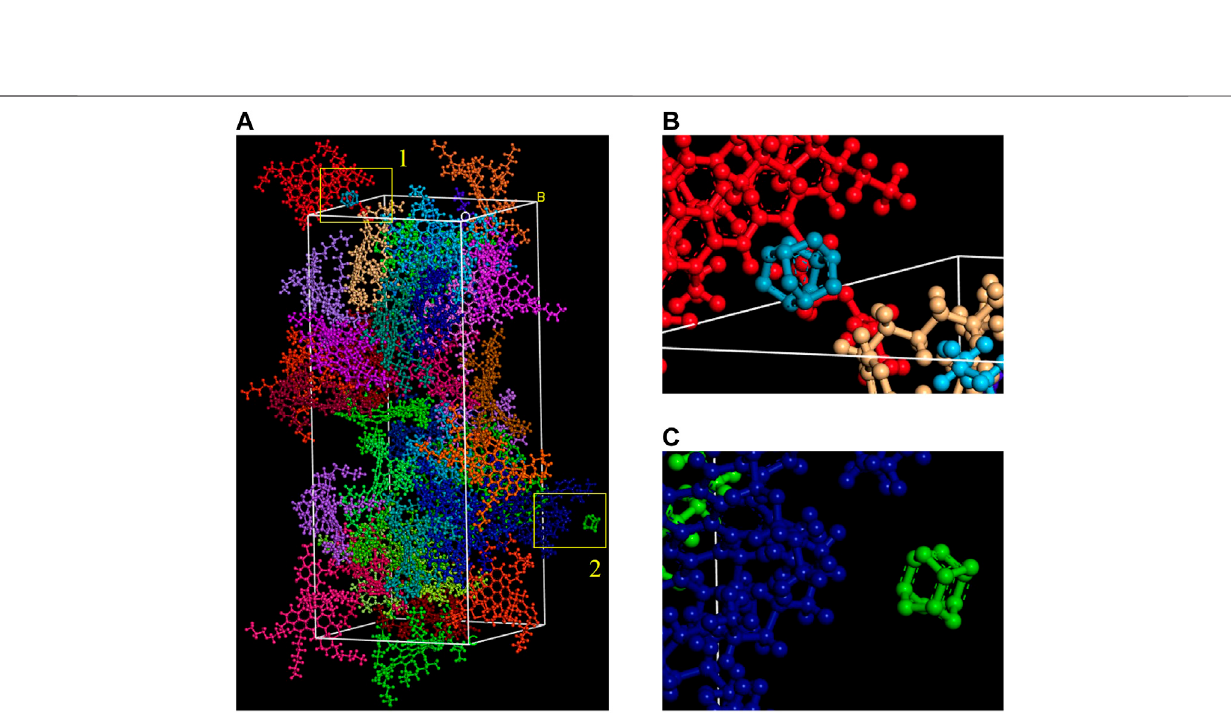
Frontiers in Materials |